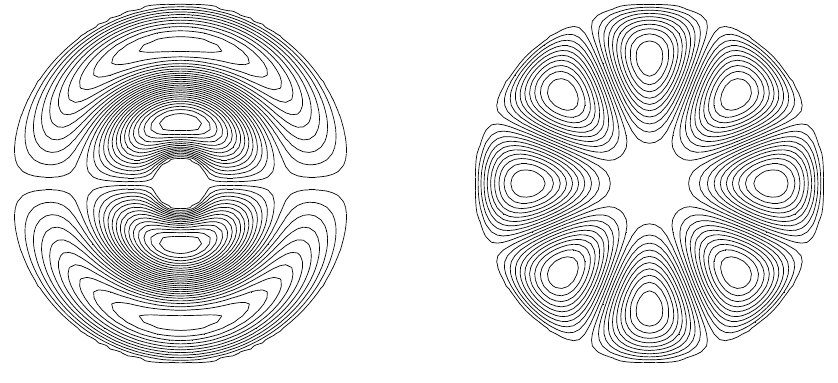
Figure 3. Plots of two independent eigenfunctions of the Laplace operator with homogeneous Dirichlet boundary conditions on an annular domain. Despite the fact that they look totally different, the domain has been dimensioned in such a way the corresponding eigenvalues are the